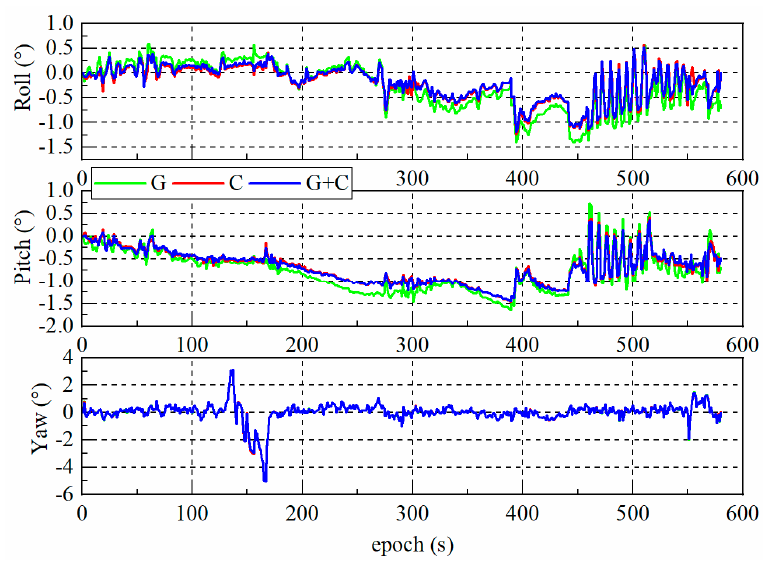
Figure 10. Attitude angle error of dual ‐ antenna GNSS/MIMU tightly coupled integration using the SVD ‐ RACKF in the case of single GPS (G), single BDS (C), and their combination (G + C). Table 3. RMS of position, velocity, and attitude error of dual ‐ antenna GNSS/MIMU tightly cou ‐ pled integration using the SVD ‐ RACKF in the case of single GPS (G), single BDS (C), and their combination (G + C).